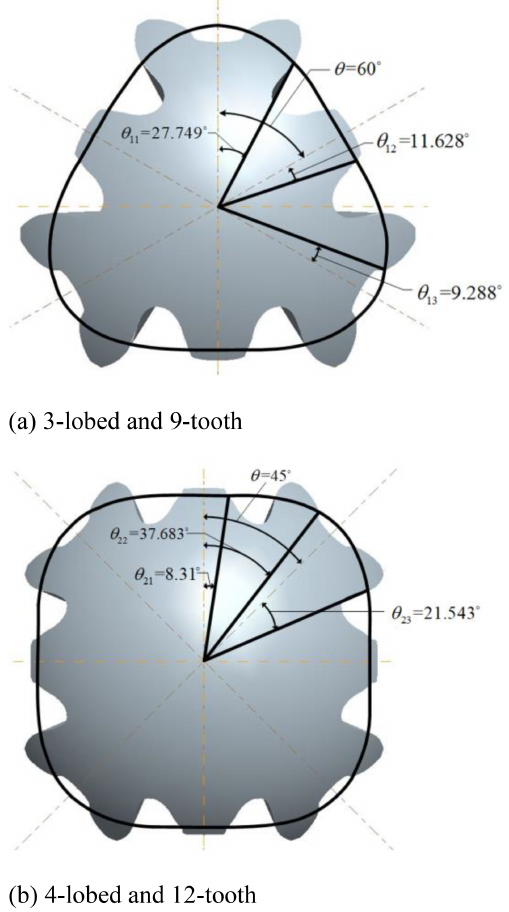
Figure 7. The perigon of noncircular bevel gears.